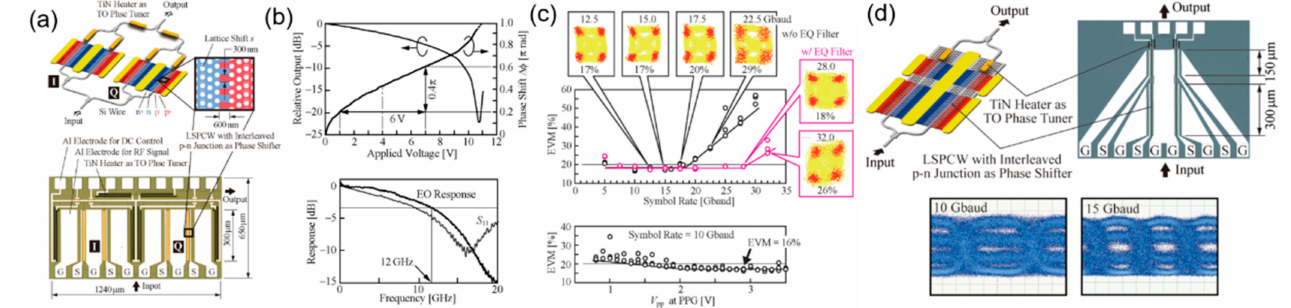
Figure 6. Silicon photonic crystal quadrature phase-shift keying (QPSK) and pulse amplitude mod- ulation (PAM-4) modulator. ( a ) Scheme and optical image of the silicon photonic crystal QPSK modulator with interleaved PN junctions [46]. ( b ) Optical intensity response and frequency response of the silicon photonic crystal modulator [46]. ( c ) QPSK modulation results: EVM and constella- tion pattern [46]. ( d ) Silicon photonic crystal PAM-4 modulator: Scheme, optical image, and eye diagram